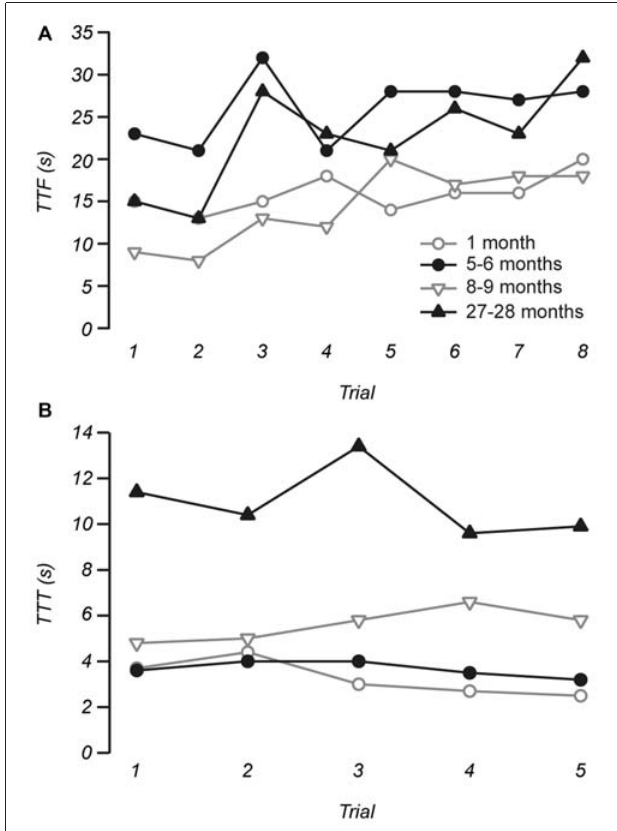
FIGURE 1 | Example measurements of time to fall (TTF) from the rotarod and time to traverse (TTT) the balance beam . (A) The stability of TTF measurements was assessed by plotting TTF as a function of individual trials for each individual mouse. Across our sample and for the four individuals shown trials 1 to 3 on the rotarod were considered as training trials, while the stable measurements of the remaining five trials were used for data analysis. (B) Measurements of TTT on the balance beam were stable across trials, with trials 1 to 4 used as practice and measurements made from trial 5 were used to represent performance prior to the vestibular